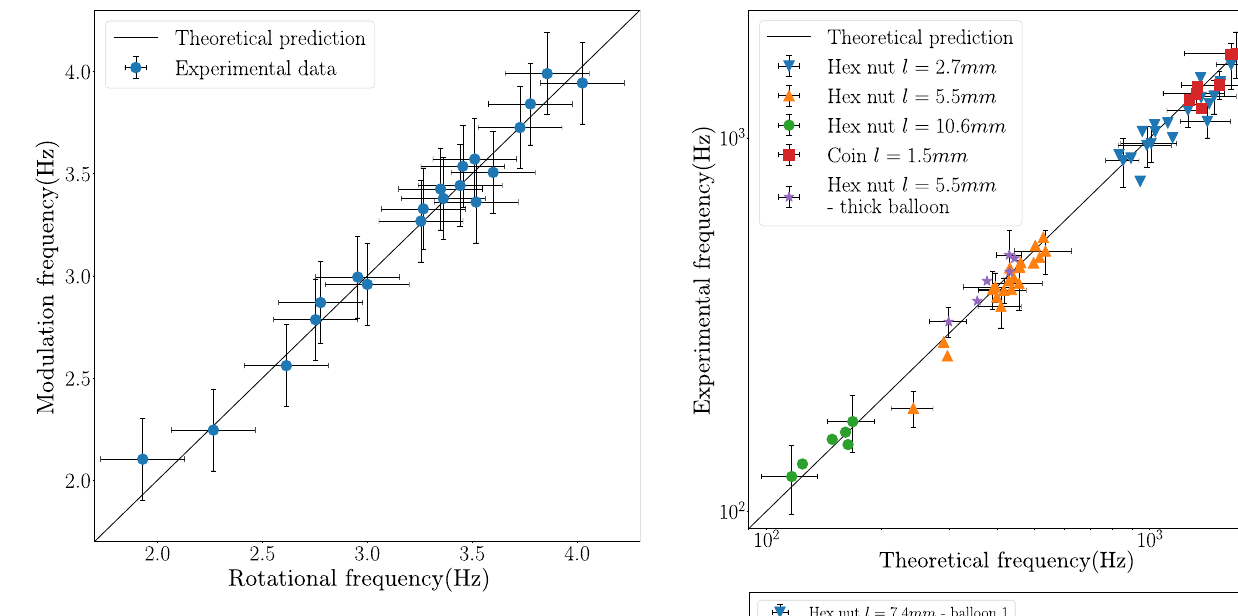
Fig. 5. Amplitude modulation frequency plotted against the macroscopic rotational frequency of the nut. The frequency was averaged over a period of 10 modulations for each experiment. The macroscopic rotational frequency was derived from videos of the balloon taken at 30 fps, using a regular camera.